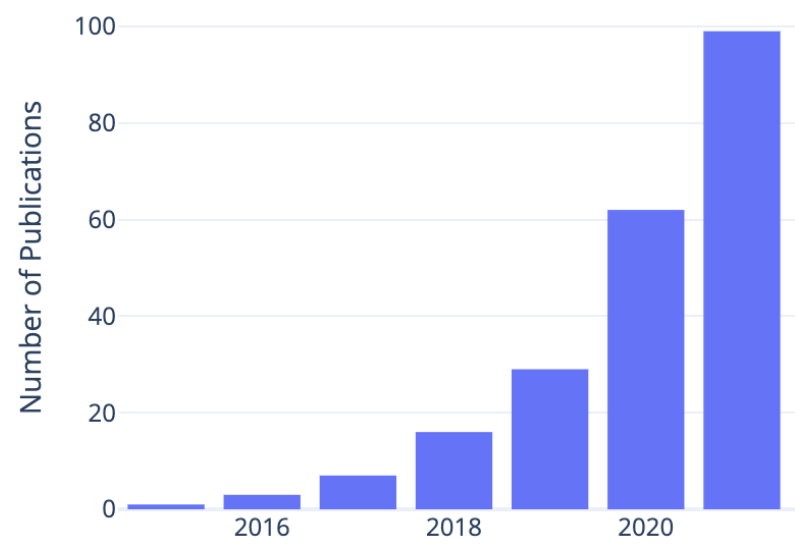
Figure 1. Interest in using deep learning-based methods for 3D reconstruction is reflected in the number of publications on ScienceDirect matching the keywords “3d reconstruction” AND “deep learning”, which have been exponentially growing since